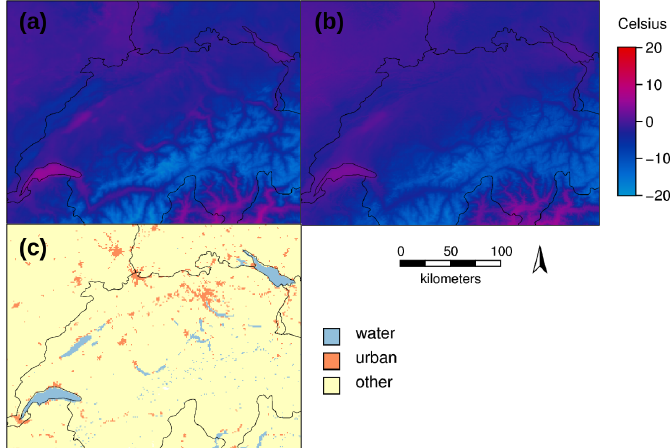
Figure 7. Results of LST reconstruction for January 2015: ( a ) with emissivity as additional variable; ( b ) without emissivity (c.f, old “EuroLST” from [5]); and ( c ) corresponding land cover types. The displayed area covers Switzerland and parts of France and Germany. The slightly higher temperatures of urban areas are represented, and water bodies are more clearly delineated when considering